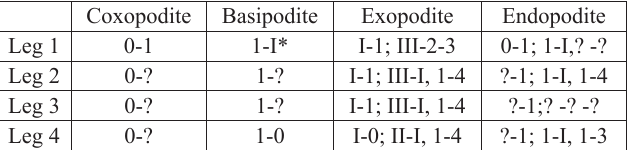
Table 1. Armature of leg 1–4 in the adult female of Apocyclops califor- nicus sp. nov. Spines are denoted by Roman, setae by Arabic numer- als. The armature on the lateral margin of any segment is given first, followed by the elements on the apical and medial margins.? element could not be verified; * presence of the medial spine on P1 basipodite was inferred from the presence of this spine in the adult male and copepodid V.